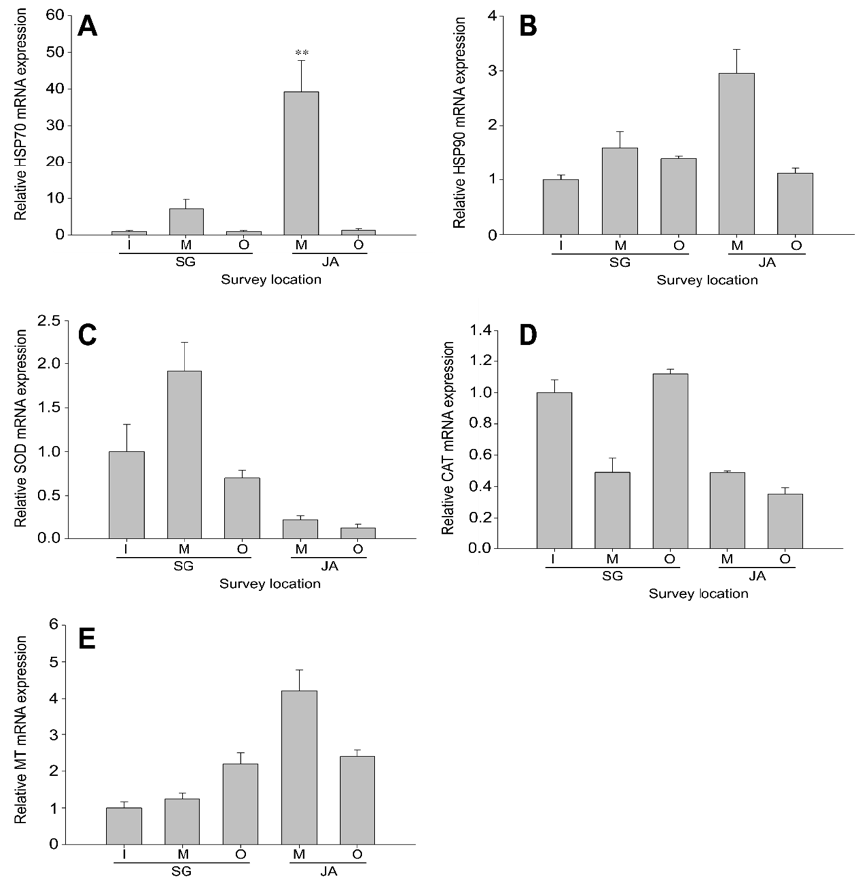
Figure 3. Gene expression analysis of HSP70 ( A ), HSP90 ( B ), SOD ( C ), CAT ( D ), and MT ( E ) in Zacco platypus liver. The data are presented as the mean ± SD. The expression levels of each gene were compared with the expression level in Singal Lake inflow (expression level = 1). Significant differences are indicated with asterisks: ** p < 0.01.